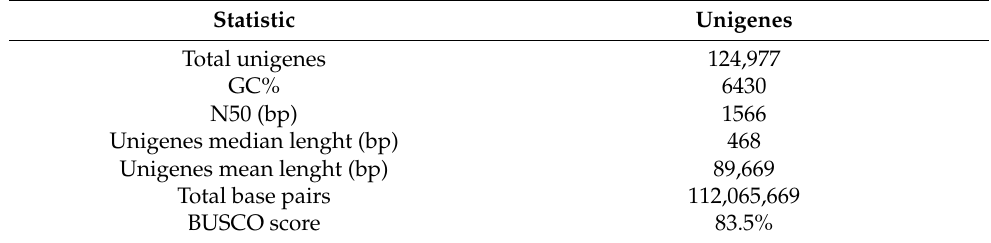
Table 1. Statistical summary of A. minutum unigenes generated using de novo assembly